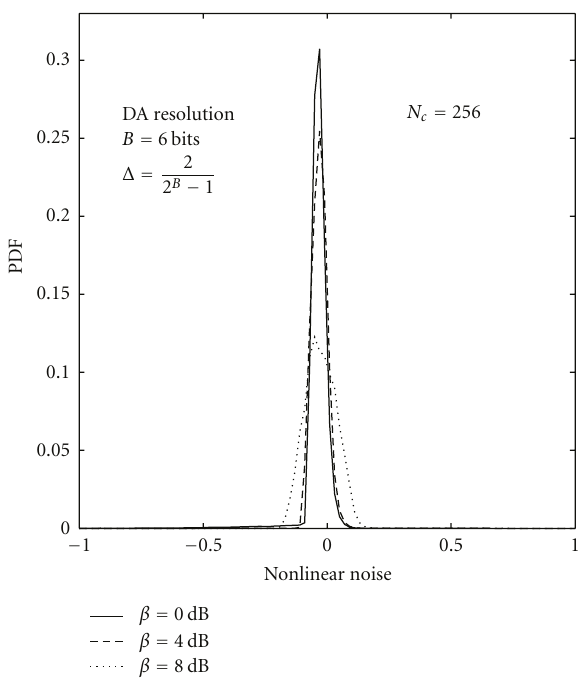
Figure 7: PDF of the nonlinear